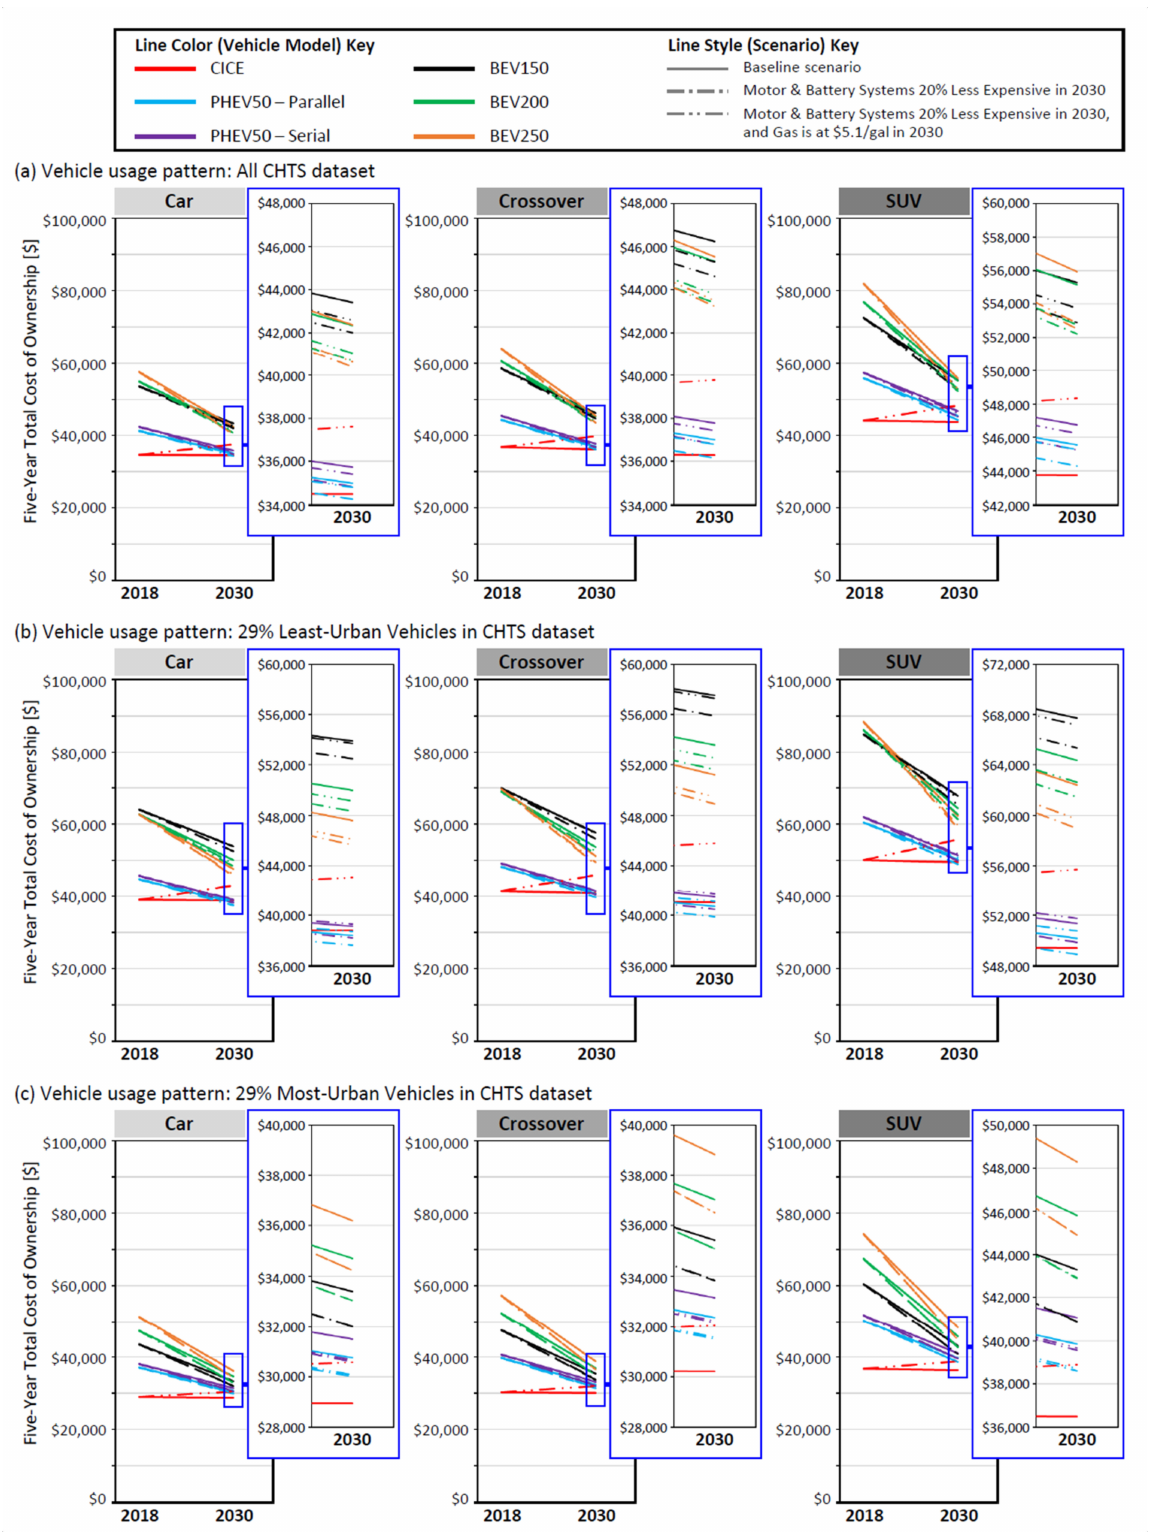
Figure 4. Total cost of ownership for different vehicle usage patterns, with sensitivity analysis for 2030 scenarios. ( a ) Driving patterns from all CHTS dataset ( b ) Less-urban driving patterns obtained from the 29% least urban vehicles in CHTS dataset ( c ) More-urban driving patterns obtained from the 29% most urban vehicles in CHTS